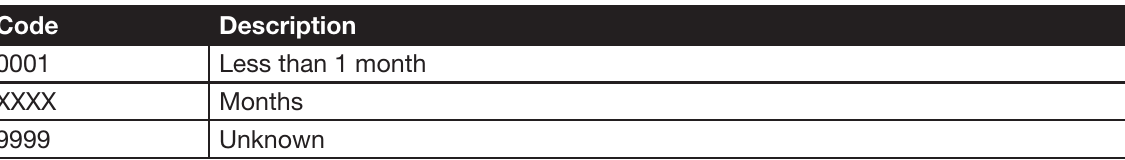
INTIMATE PARTNER VIOLENCE: UNIFORM DEFINITIONS AND RECOMMENDED DATA